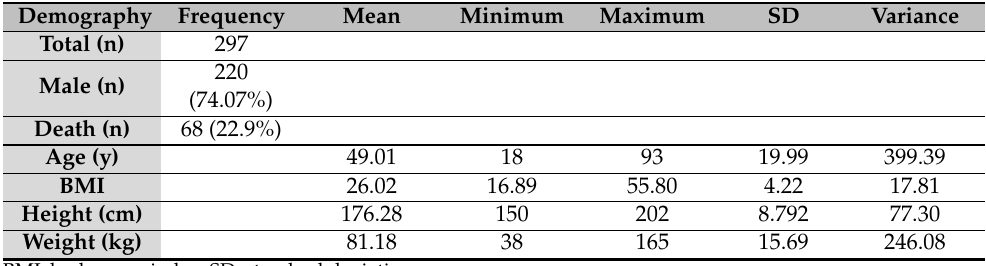
Figure 3. Flowchart showing the formation of the cohort. Table 1. Demographic data.